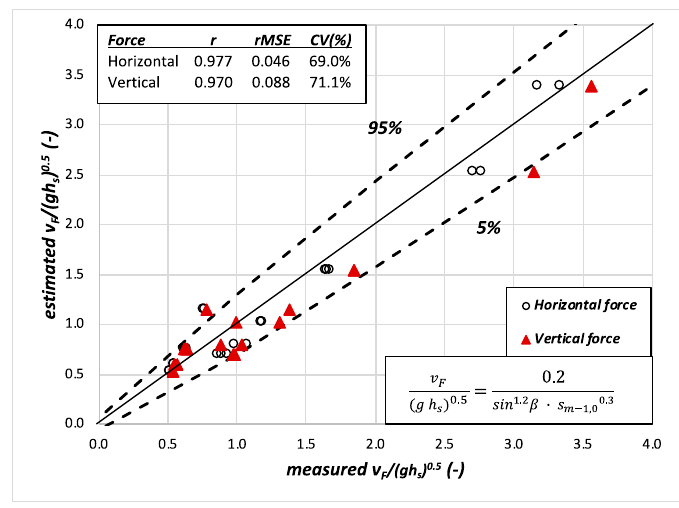
Figure 17. Comparison between the measured and estimated v F /(g h s ) 0.5 using Equation (10).